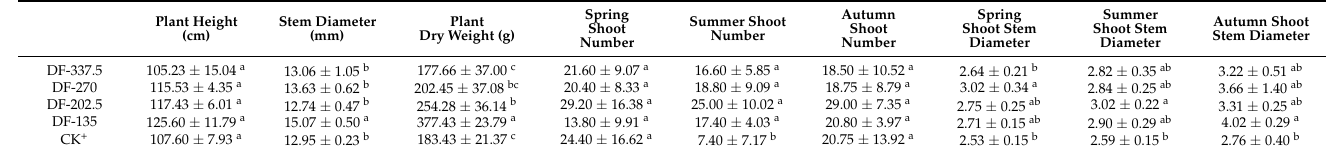
Table 4. Citrus plant growth with reducing fertilization amount using fertigation.